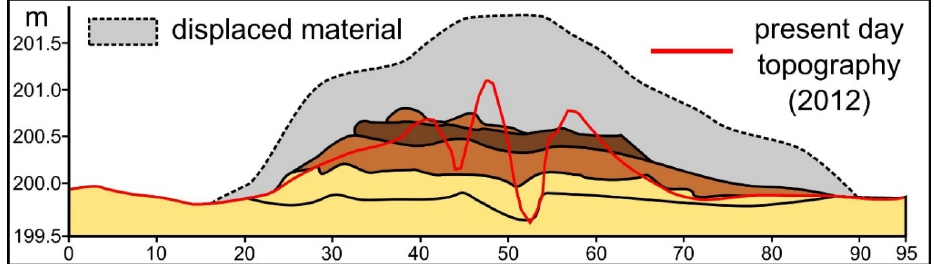
Figure 3. The stratigraphy of a burial mound (yellow to brown and grey) excavated by [61] at Corl ăţ e ş ti (Boto ş ani, County), redrawn after [61] with overlayed present-day LiDAR topography (red line); the location of this mound is represented in Figure 2 of [63], available in high-resolution at https://doi.org/10.1371/journal.pone.0227335.g002 or https://doi.org/10.6084/m9.figshare.11340419. (a high-resolution version can be found at https://doi.org/10.6084/m9.figshare.11798616.v1)